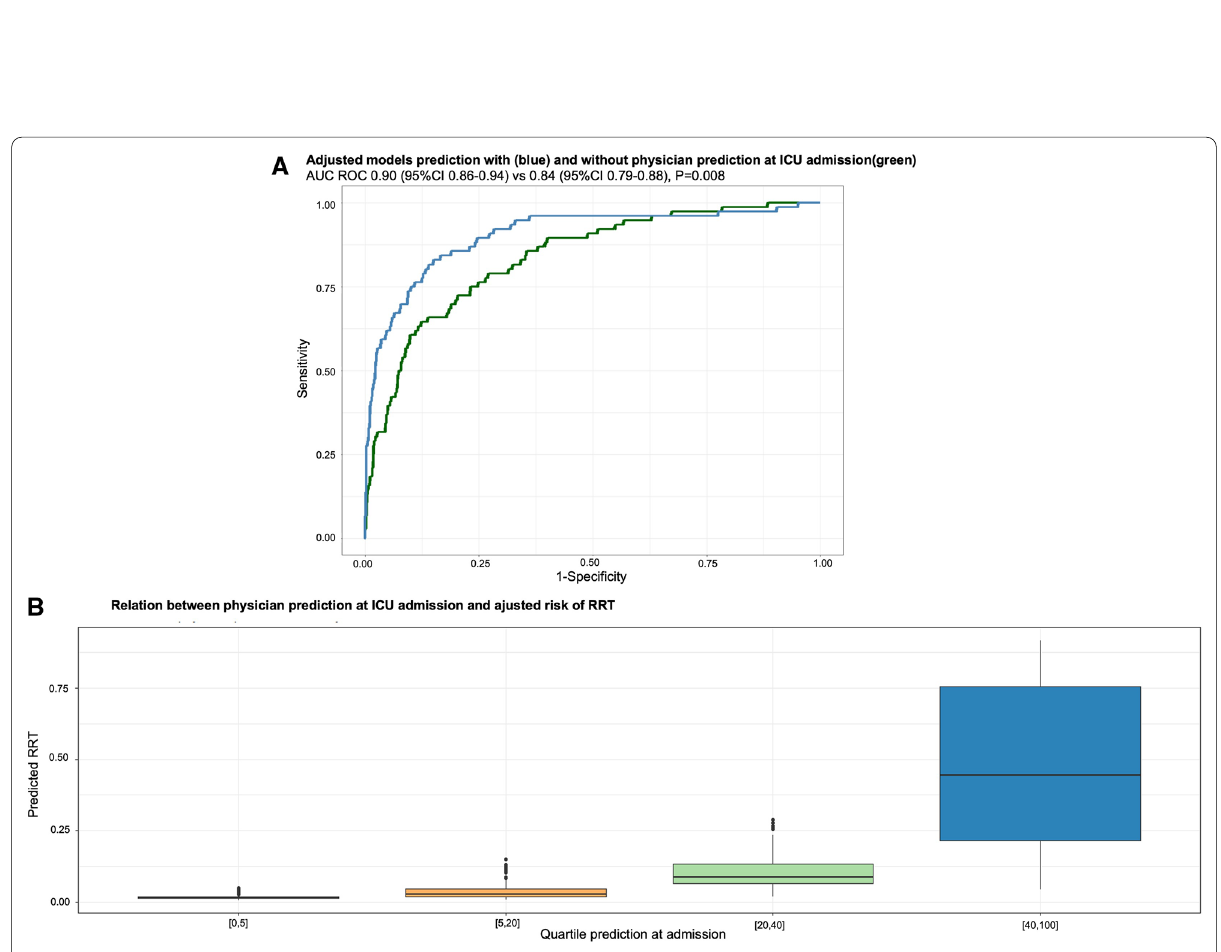
Fig. 2 Adjusted models prediction of physician prediction at ICU admission ( A ) and relation between physician prediction and adjusted risk of RRT ( B ). ICU intensive care unit, RRT renal replacement